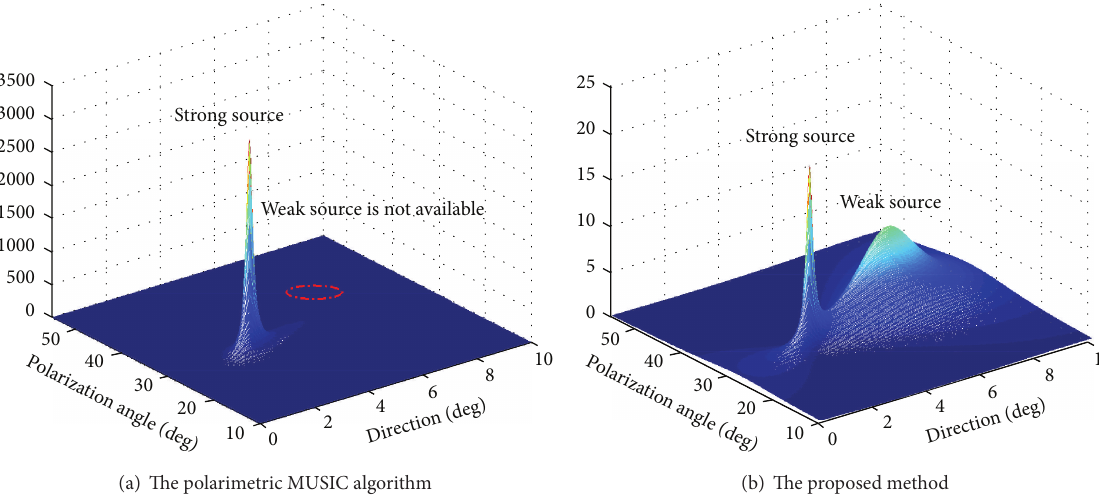
Figure 2: Spectrums of the DOA and polarization estimation, where the strong source is located at (𝜃 1 ,𝛾 1 ) = (3 ∘ ,30 ∘ ) SWR and the weak source is located at (𝜃 2 ,𝛾 2 ) = (7 ∘ ,35 ∘ )